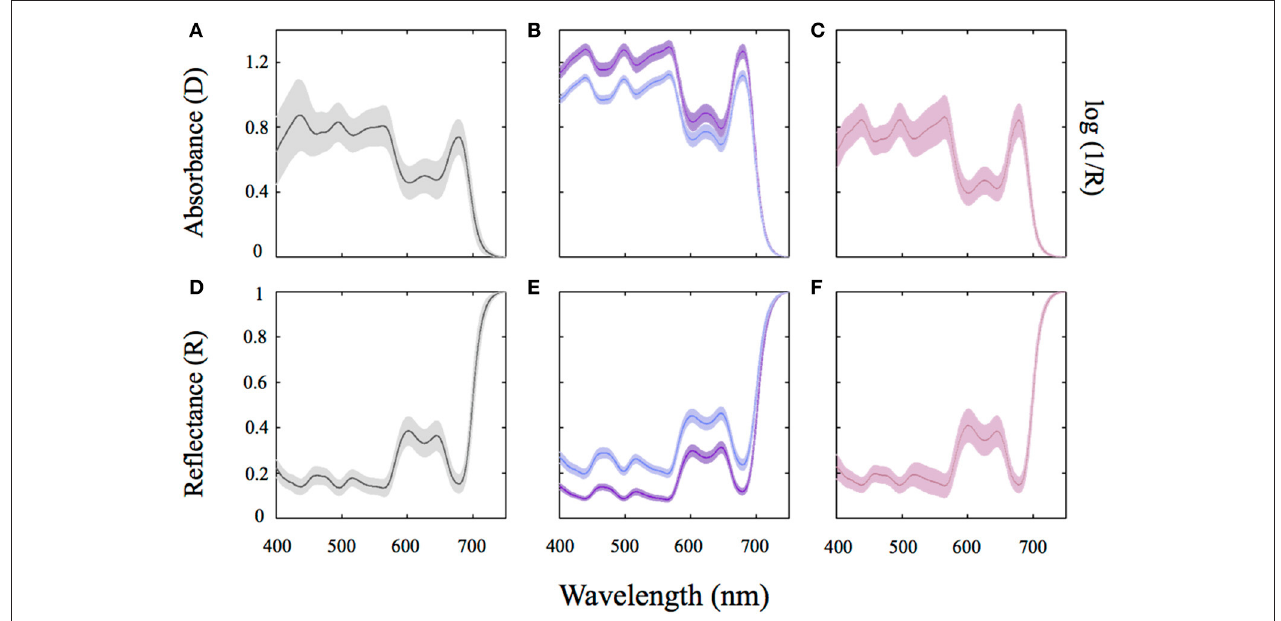
FIGURE 3 | Absorption and reflectance spectra of the three coralline algae characterized in this study. Average absorbance (D) for thallus spectra of the CCA Lithothamnion sp (A) and the articulated alga Amphiroa tribulus (B) ; Average absorption spectra of thalli of the rhodolith forming species Neogoniolithon sp. using reflectance (R) determinations and the transformation log(1/ R ) (C) . (D–F) Show the respective average reflectance (R) spectra of the coralline species studied. The solid line represents an average spectrum of ≥ 8 independent spectra whereas the shaded area represents the SD of the mean. Color of the lines: pink for the rhodolith Neogoniolithon sp.; Purple and blue for highly pigmented (HP) and lesser pigmented (LP) sides of the articulated alga Amphiroa tribulus; And gray for the crustose coralline (CCA) Lithothamnion